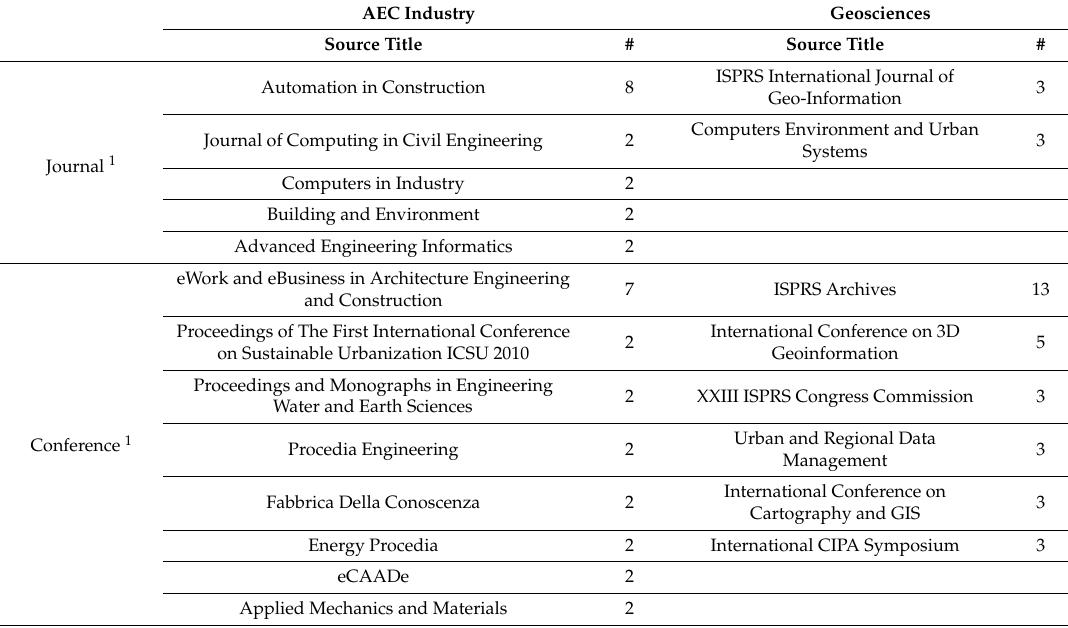
Table 2. Summary of journals and conferences for the publications of BIM-GIS integration.